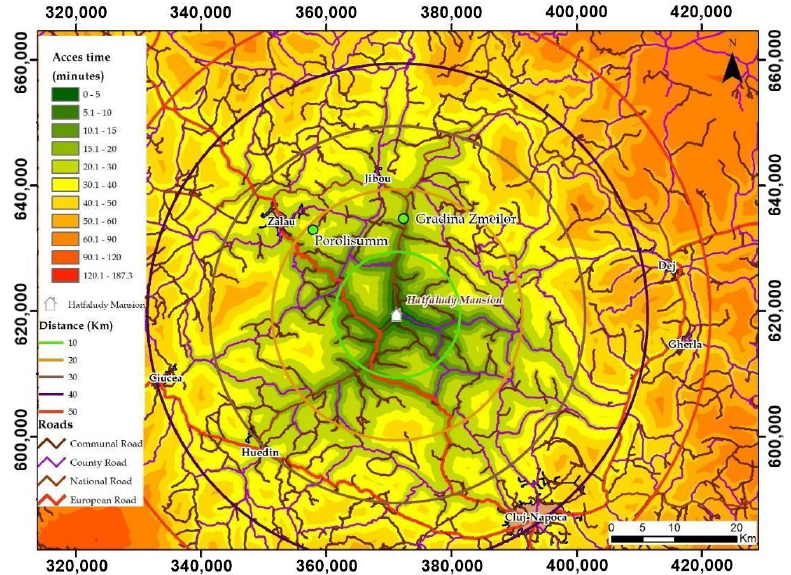
Figure 18. Accessibility assessment from the main surrounding cities (Cluj-Napoca and Zalau) and to